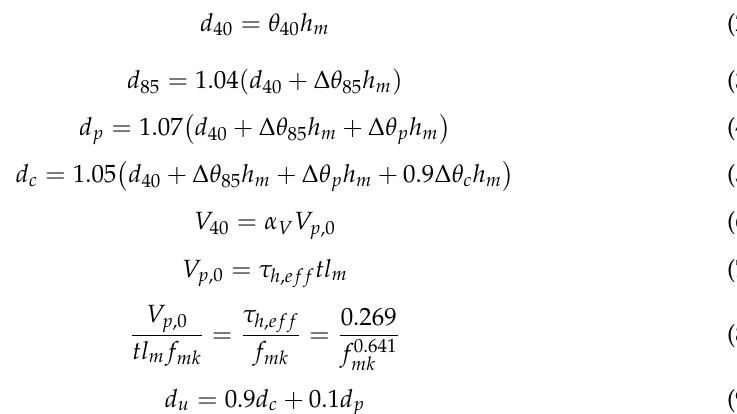
Figure 6. The skeleton curve model of infill. θ= 40